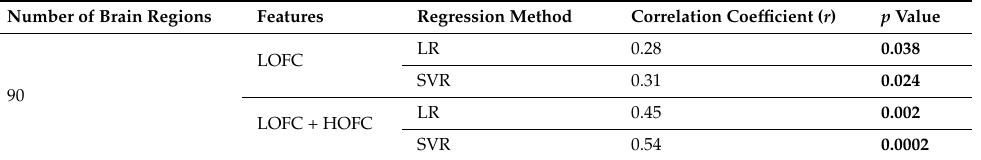
Table 2. Accuracy of predicting TDT scores from stroke participants using resting-sate functional connectivity. Note: Significant p values are in bold font.